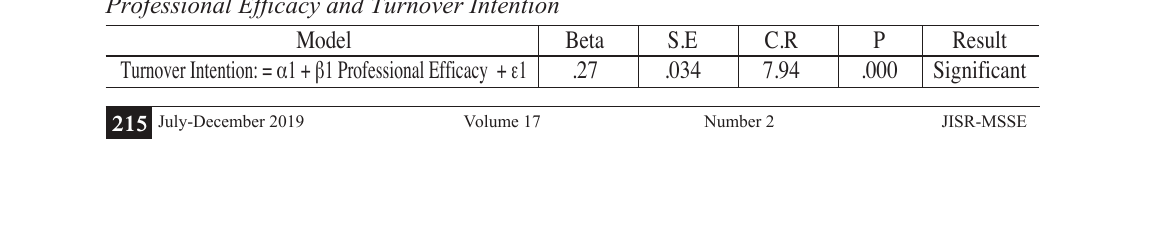
Cynicism and Turnover Intention Model Beta